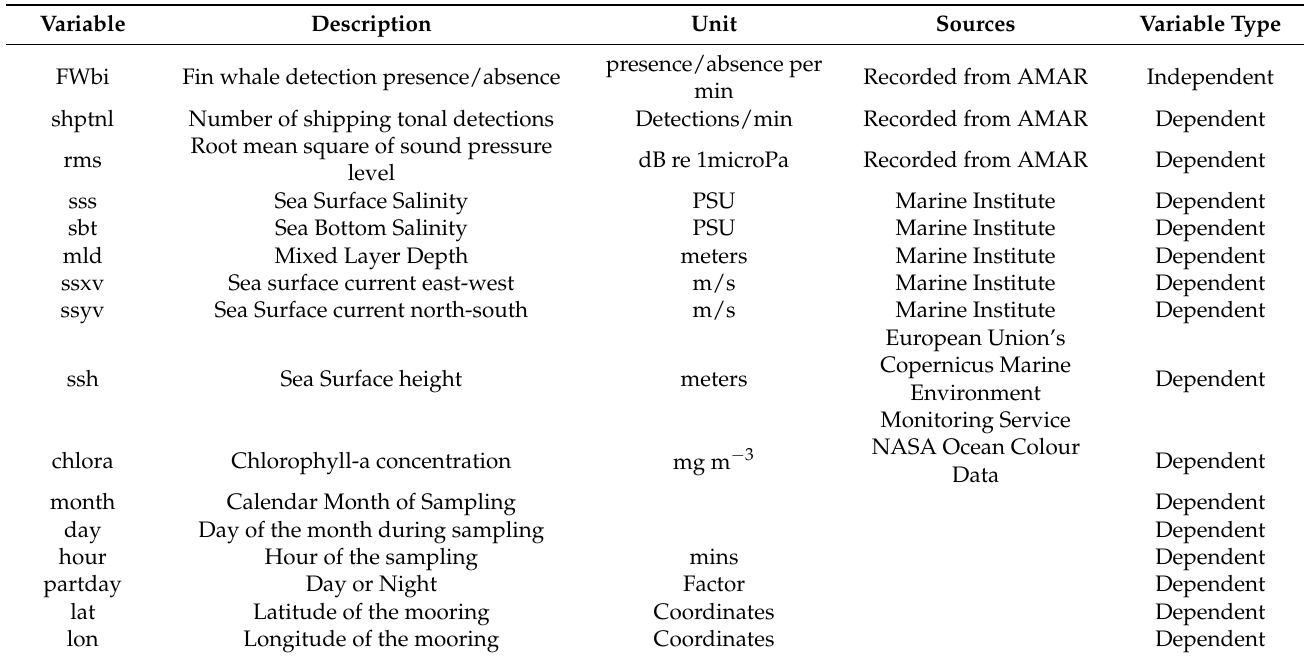
Table 1. Description of variables used in the analysis along with its sources where applicable.